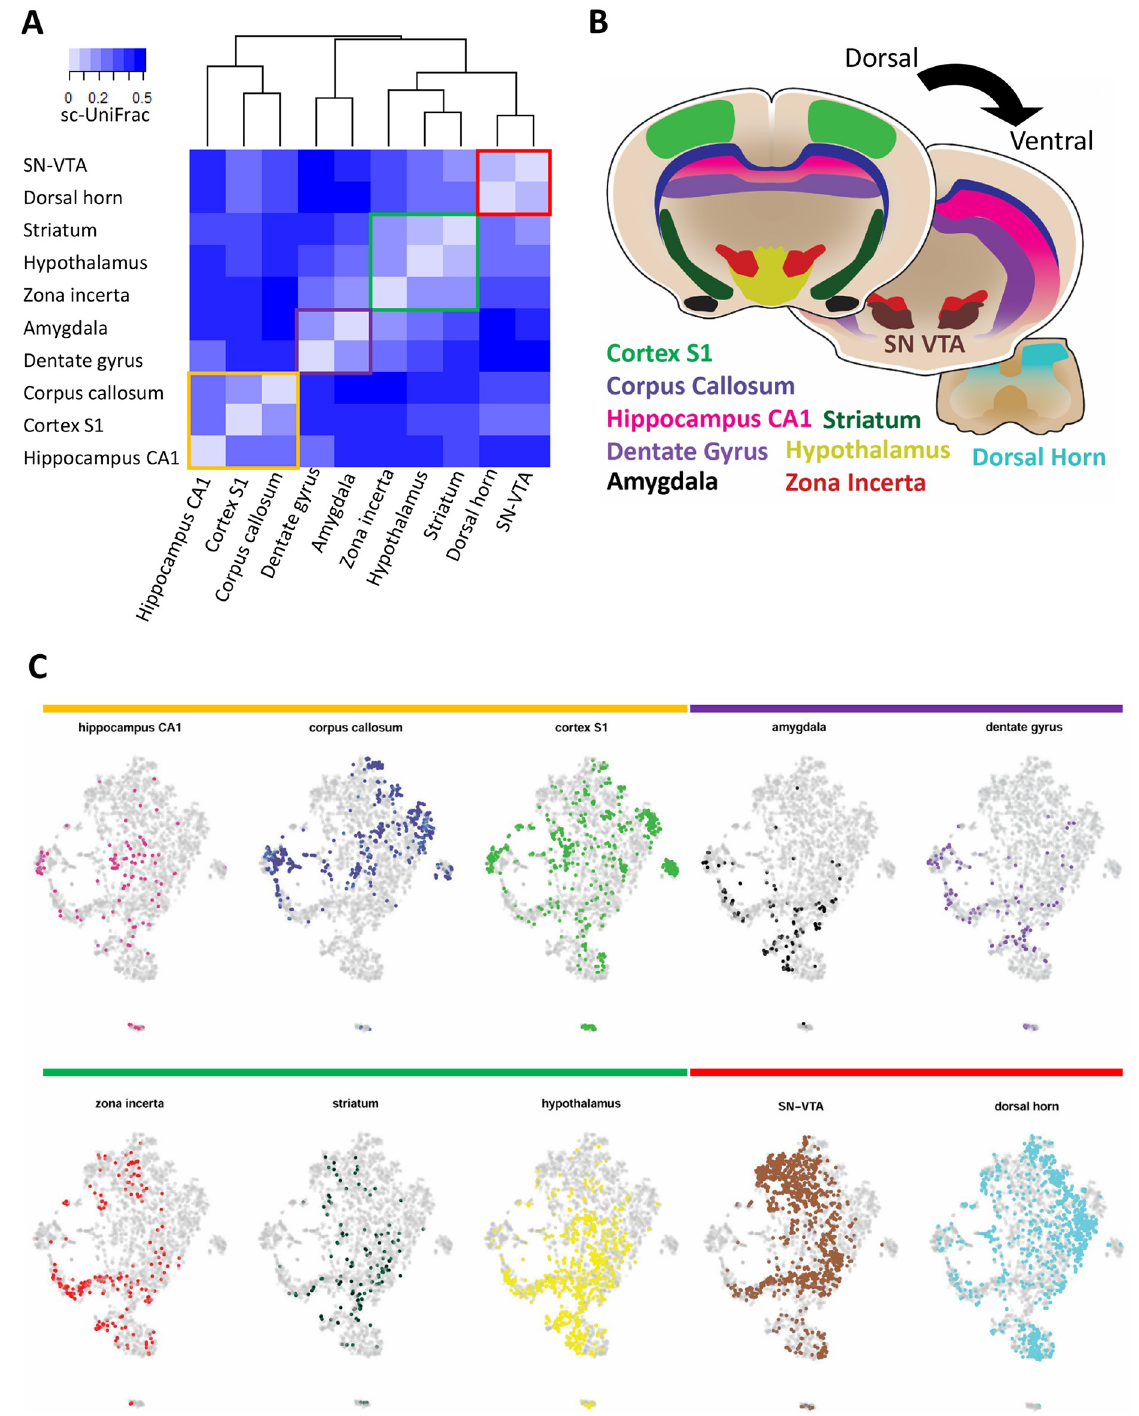
Fig 7. sc-UniFrac groups oligodendrocytes by brain regions. (A) Hierarchical clustering by sc-UniFrac of scRNA-seq data generated from different regions of the brain according to [29]. Heat represents sc-UniFrac distance between two regions. (B) Schematic of brain regions for generating scRNA-seq data. (C) t-SNE plot of data combined from all brain regions, with oligodendrocytes from each region highlighted. Data from GSE75330. scRNA-seq, single-cell RNA sequencing; SN-VTA, substantia nigra and ventral tegmental area; t-SNE, t-distributed stochastic neighbor